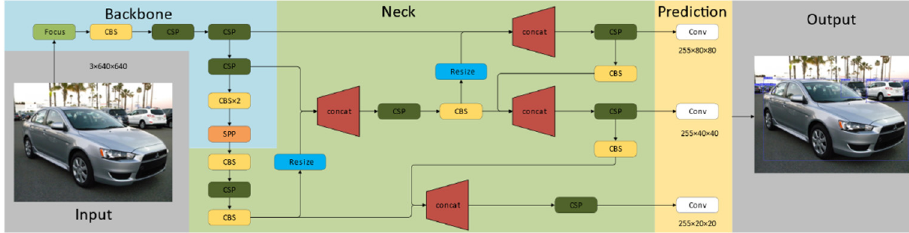
Figure 3. YOLO-v5s network structure.